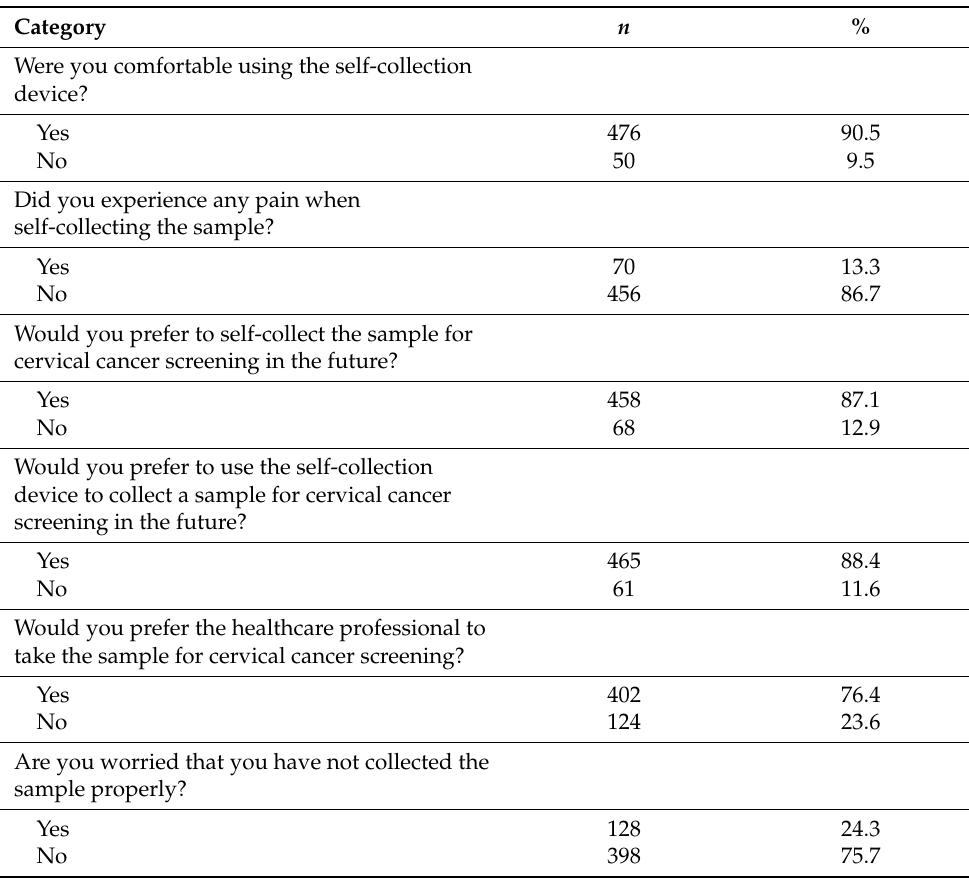
Table 4. Experience and preferences of self-sampling ( n =